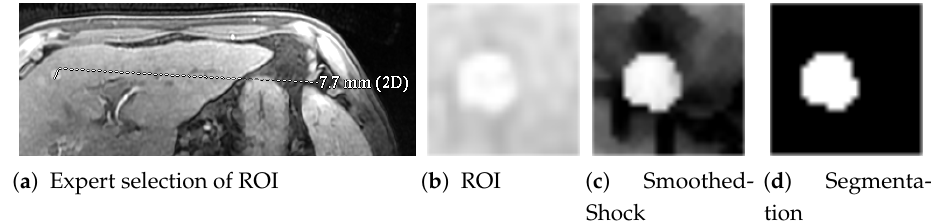
Figure 10. The steps of HCC segmentation from MRI